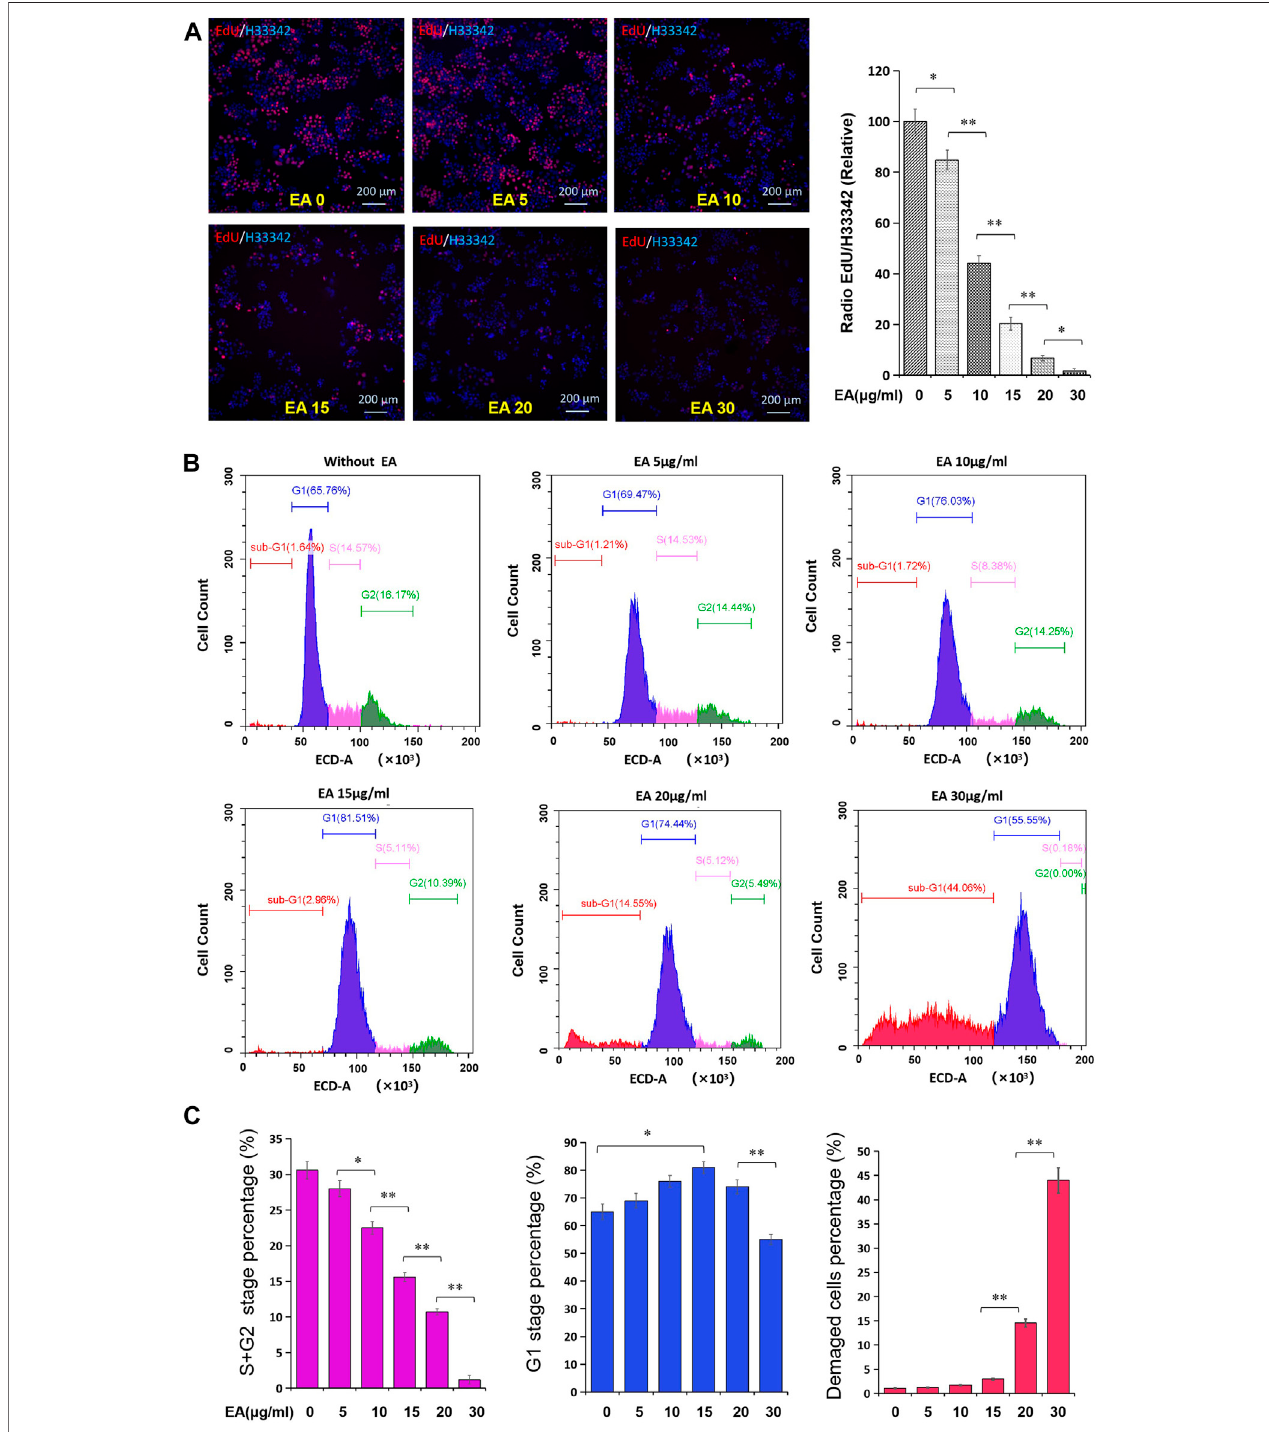
FIGURE 4 | EA attenuated cell cycle of colorectal cancer cells. (A) The impact of EA on DNA synthesis of colorectal cancer cells was tested by the EdU kit. EdU positive stained cells were shown in red, and the cell nucleus stained by Hoechst33342 were shown in blue. The inset showed a quantitative calculation of the inhibitory effect of EA on DNA synthesis. The difference was calculated by a two-way t -test, * p < 0.05, ** p < 0.01. (B) The impact of EA on cell cycle was investigated by fl ow cytometrywithPIstaining.BlueregionrepresentedthecellsintheG1phase,rose-pinkregionrepresentedthecellsinSphase,greenregionrepresentedthecellsin theG2phase,andredregionrepresentedthedamagedordefectivecells. (C) ThepercentageoftheSandG2stagewasquantitativelyshowninrose-pinkcolumn fi gure, the percentage of the G1 phase was shown in blue column, and the percentage of damaged cells was shown in red column.